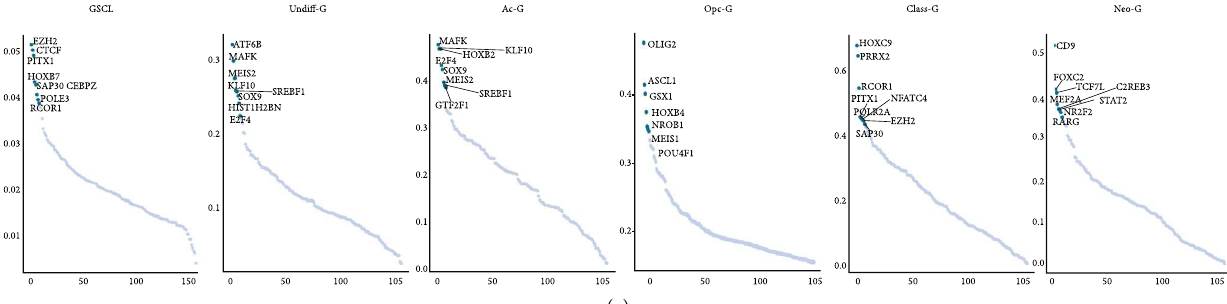
Figure 4: Transcriptional distinguishment between the four di ff erentiation trajectories of tumor cells. (a) Di ff erences in total GO pathway enrichment between the seven tumor clusters. (b) Di ff erences in total transcripts between the seven tumor clusters. (c) Di ff erences in the proportion of cell cycle phases in GSCL and malignant cell clusters. (d) Heatmap showing di ff erences in activation of pathways between the seven tumor clusters. (e) Heatmap showing di ff erences in activation of pathways related to targeted therapies in Class-G/Opc-G/Neo- G/Ac-G/Undi ff -G clusters calculated by GSVA method. (f) Heatmaps of di ff erences in single-cell copy number between the tumor clusters and other cell clusters. (g) TF activity in the GSCL/Undi ff -G/Ac-G/Opc-G/Class-G/Neo-G clusters. The top 7 activated TFs were marked in each